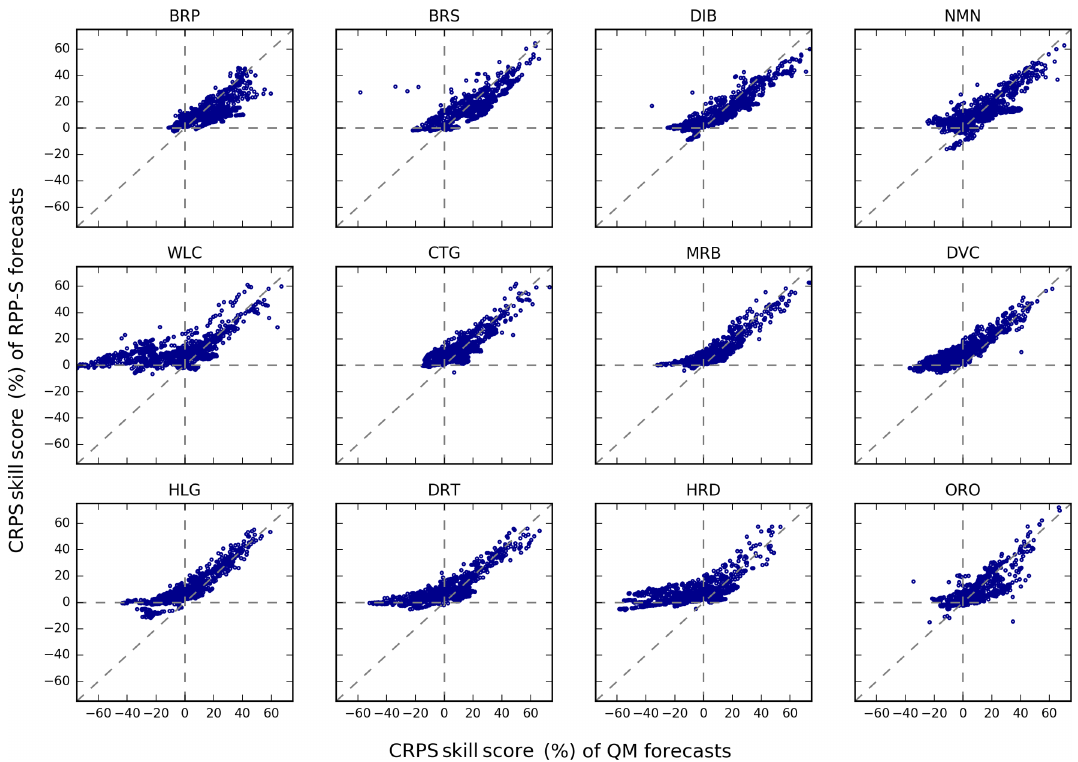
Figure 7. Scatterplots of CRPS skill scores for accumulated totals for each catchment. The scatterplots plot QM skill scores (horizontal axis) against RPP-S skill scores (vertical axis). Each scatterplot combines results for all initialisation dates and all lead times.